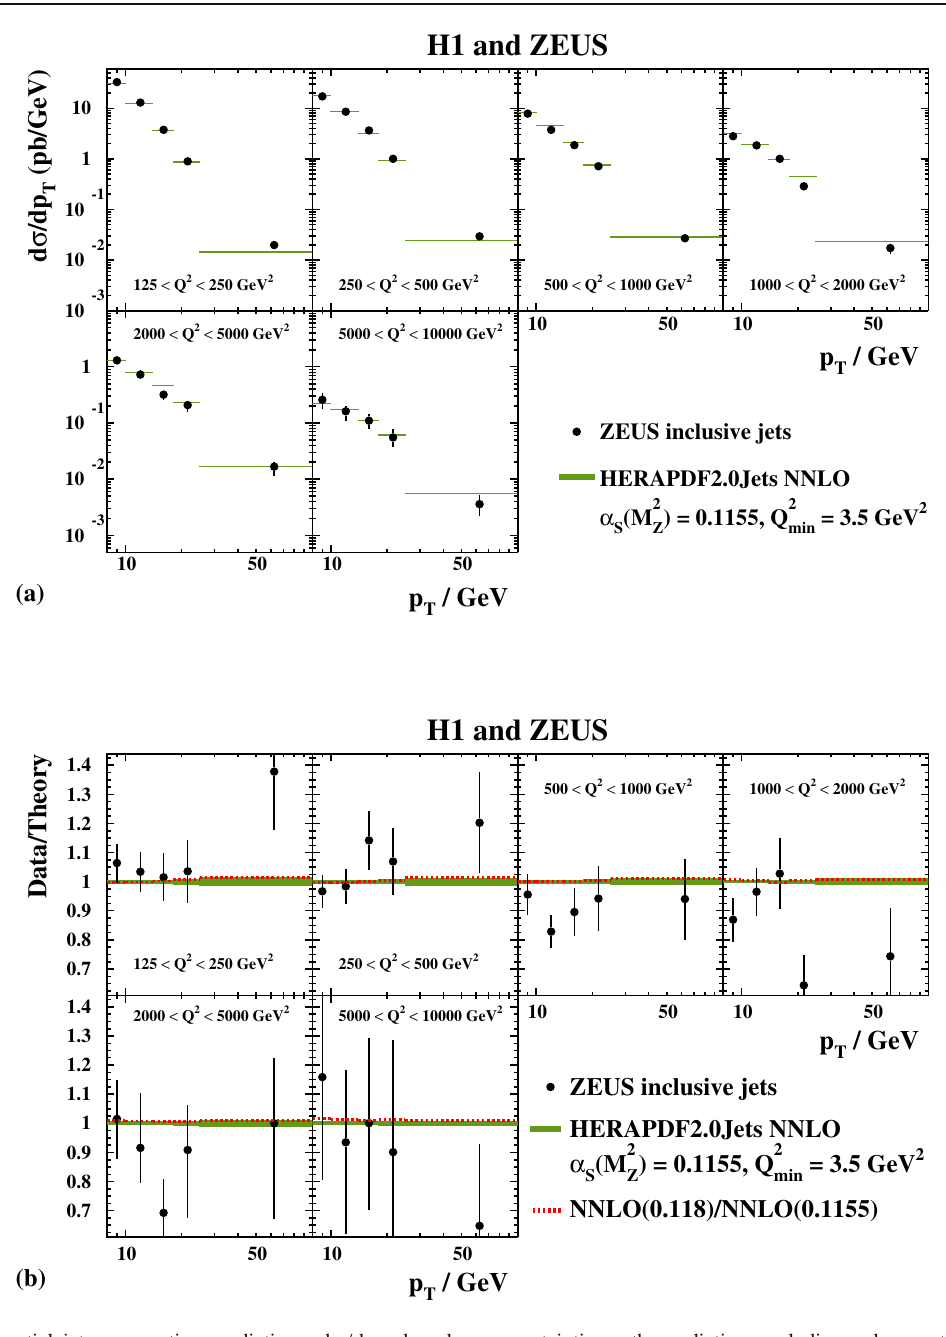
Fig. 19 a Differential jet-cross-section predictions, d σ/ d p T , based on HERAPDF2.0Jets NNLO with α s ( M 2 between 125 and 10,000GeV 2 compared to ZEUS data [11]. Only data used in the fit are shown. b Measured cross sections divided by predic- tions based on HERAPDF2.0Jets NNLO. The bands represent the total